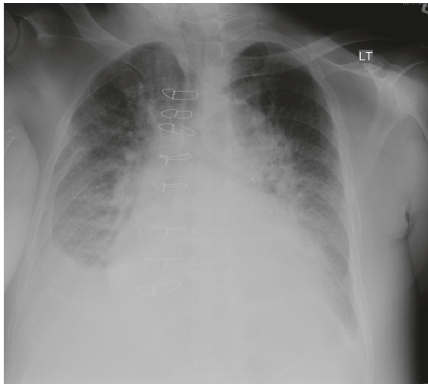
Figure 1: Portable chest radiograph on presentation showing bilat- eral basilar opacities with pleural effusions and hilar congestion.